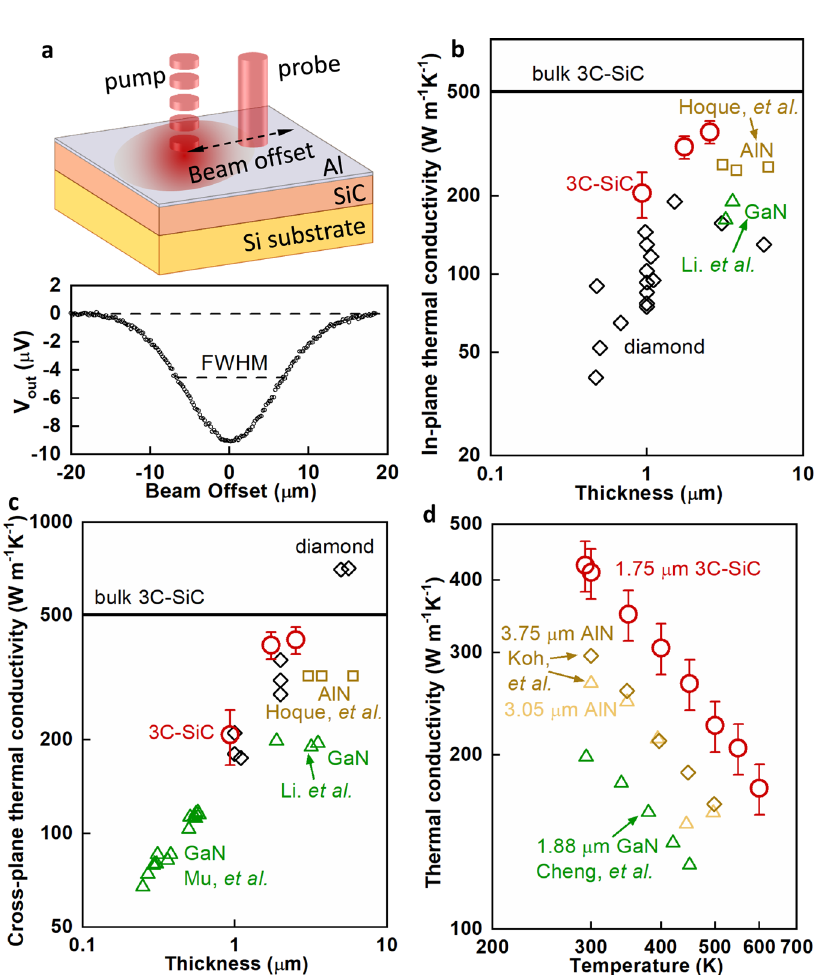
Fig. 4 | Highin-plane and cross-plane κ of3C-SiC thin fi lms.a Beam-offset TDTR techniqueforin-plane κ measurements.Theout-of-phaseTDTRsignalona2.52- μ m SiC on Sisample is shownasa function ofbeamoffsetdistance. b In-plane κ of 3C- SiC thin fi lms. The κ of 3C-SiC bulk crystal and the in-plane κ of other close-to- isotropic high κ thin fi lms are also included for comparison 32,53 – 59 . The de fi nition of